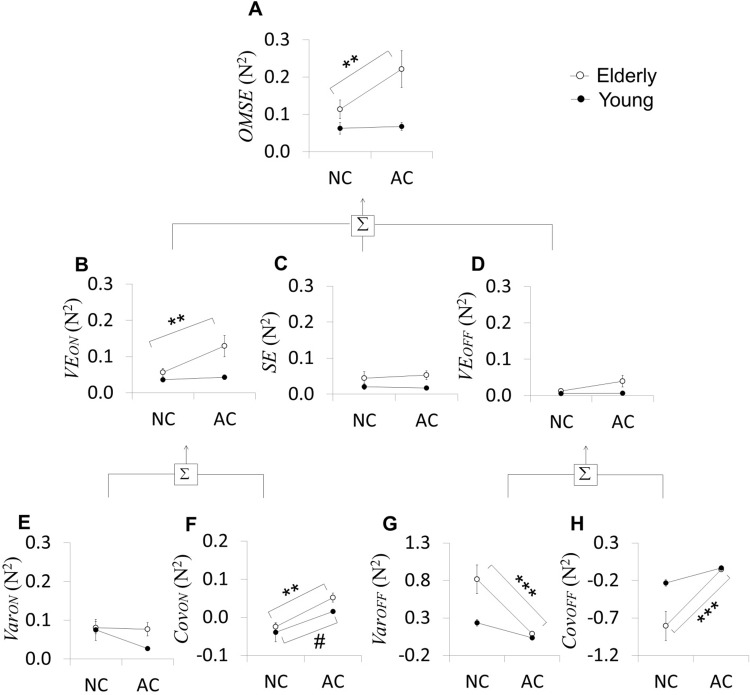
Hierarchical organization of multi-finger force.Overall mean squared error (OMSE) is shown in the top panel (A). At the VF level, the OMSE was decomposed into online variable error (VEON) (B), systematic error (SE) (C), and offline variable error (VEOFF) (D). At IF level, both VEON and VEOFF are further decomposed into VarON (E) & CovON (F) and VarOFF (G) & CovOFF (H), respectively. Error bars represent s.e.m. across subjects. Asterisks (*) and pound signs (#) indicate statistical significance of pair-wise comparisons between NC and AC tasks for the elderly group and the young group, respectively (* and # p<0.05, ** p<0.01, and *** p<0.001).